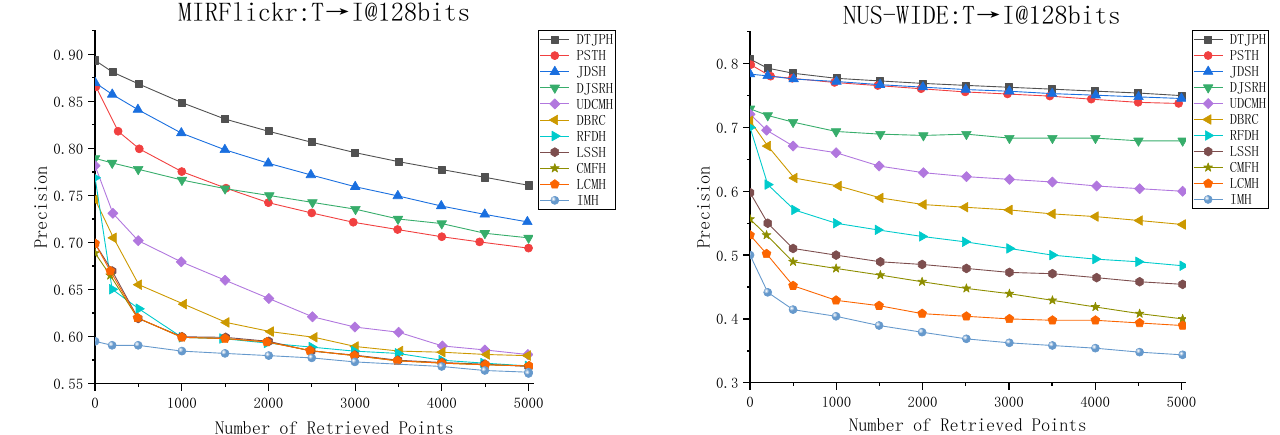
Figure 5. The top-N precision curves of text retrieving an image. The length of binary feature vectors is 128.